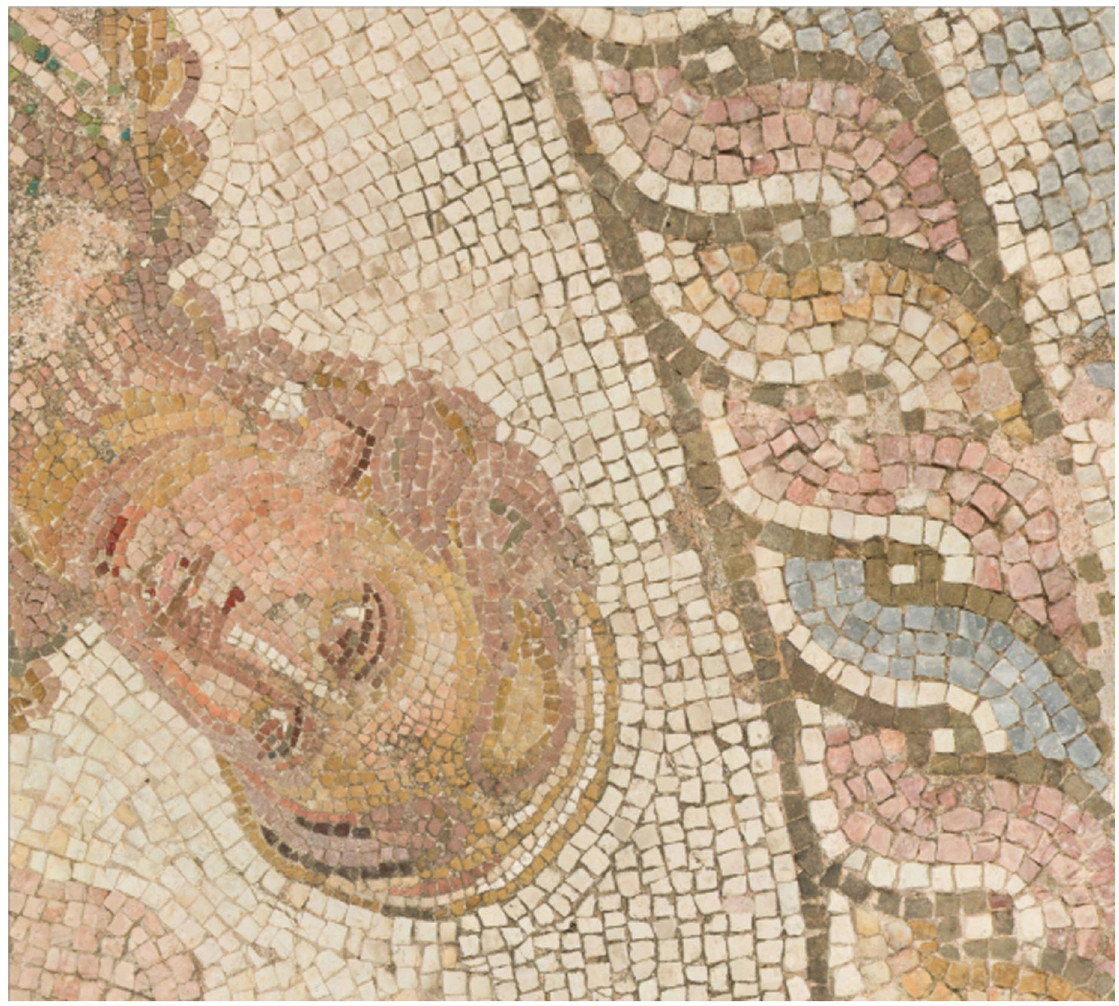
Fig. 13 Example of an ortho-corrected image showing the mosaic tesserae for conservation (Source: the